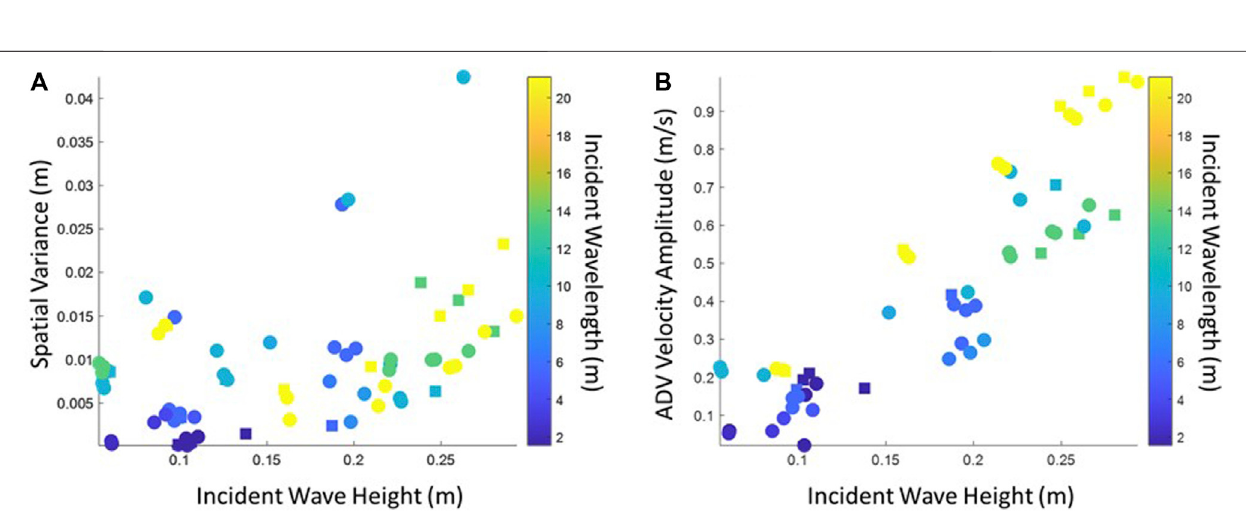
Frontiers in Built Environment |